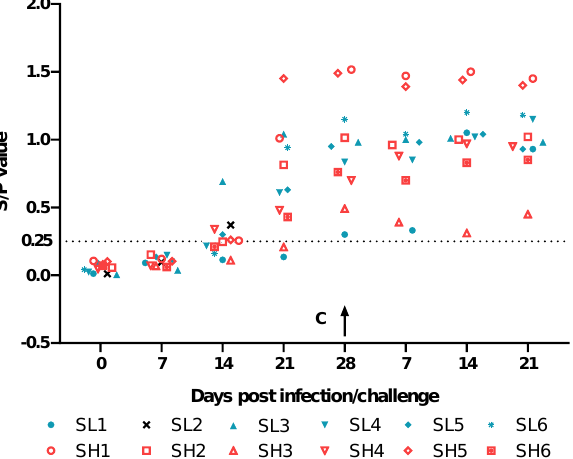
Figure 5. Assessment of ASFV-specific antibodies in pigs inoculated i.m. with 10 3 (blue, SL1–SL6) or 10 6 (red, SH1–SH6) TCID 50 SY18 △ L7-11 and challenged with 10 3 TCID 50 ASFV SY18 at 28 dpi (arrow). The pig SL2 in 10 3 group which died at 14dpi was shown in black instead of blue. The threshold 0.25 was represented by the dotted line.